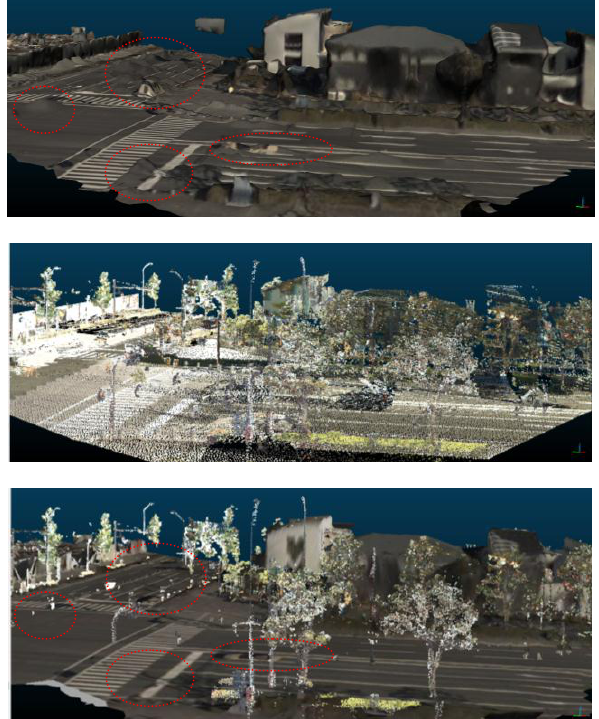
integration of the above two data sets (bottom)